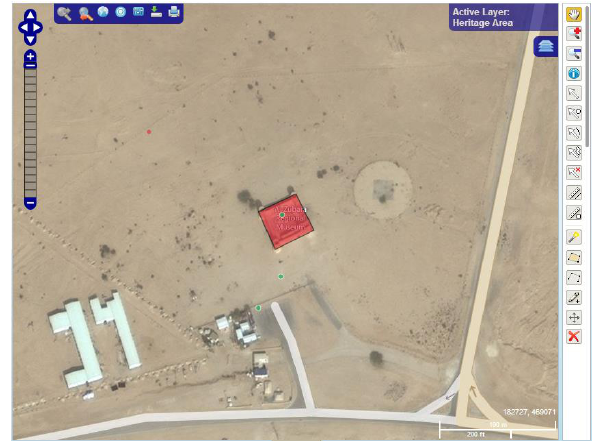
Figure 4. The mapping window